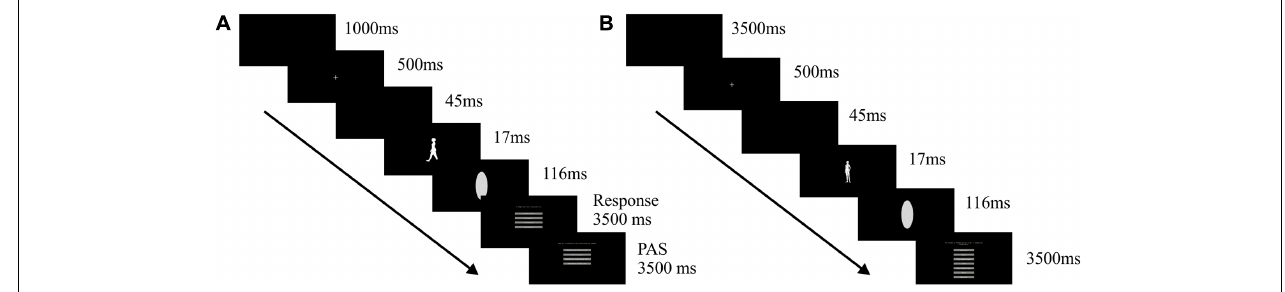
FIGURE 1 | (A) Trial sequence for experimental task 1 and (B) trial sequence for experimental task